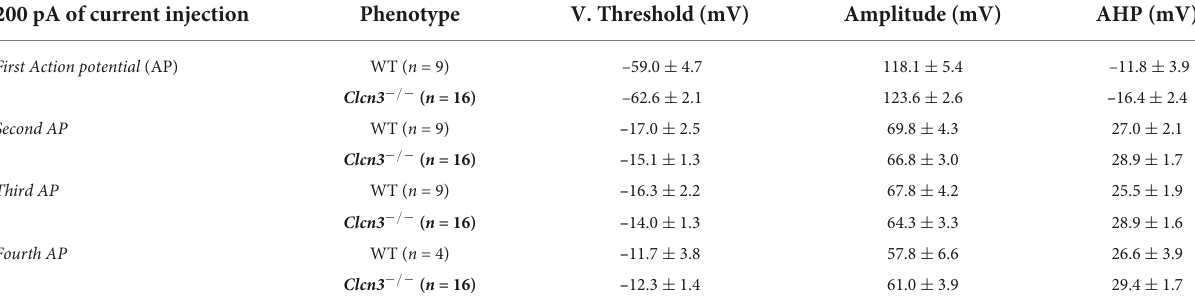
TABLE 4 Properties of the action potentials (APs) generated in response to 200 pA current injection for 1 s were not different between wild type (WT) and ClCn3 − / − adult dorsal root ganglion (DRG)